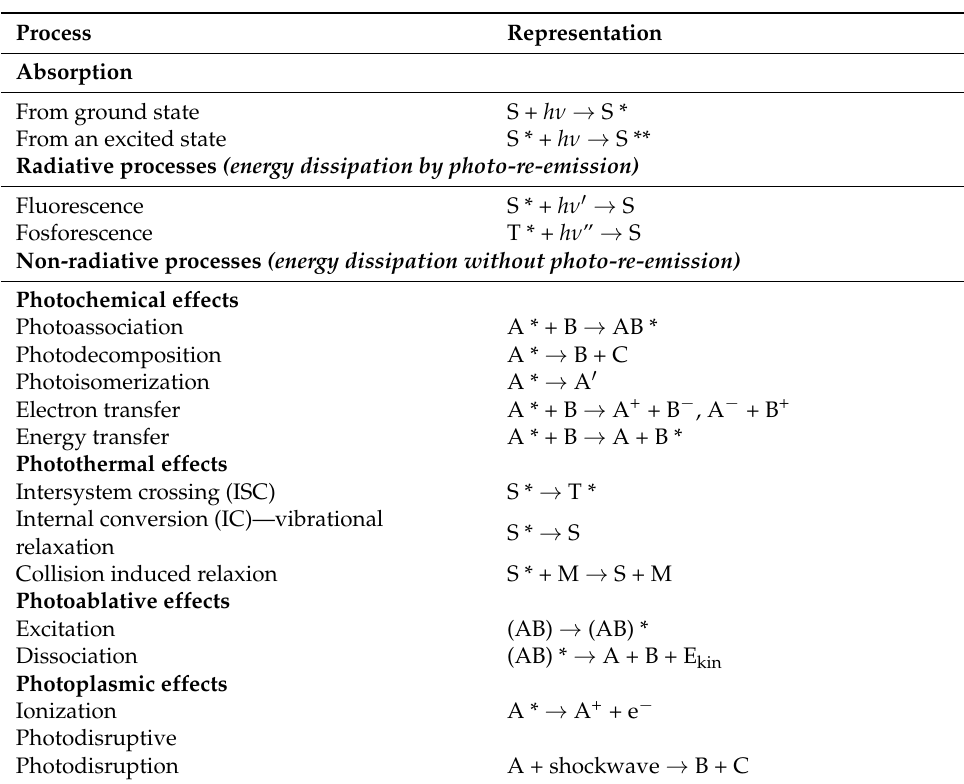
Table 1. Non-radiative relaxion pathways (taken from Boudoux, 2016). * and ** refers to excited and double-excited states,